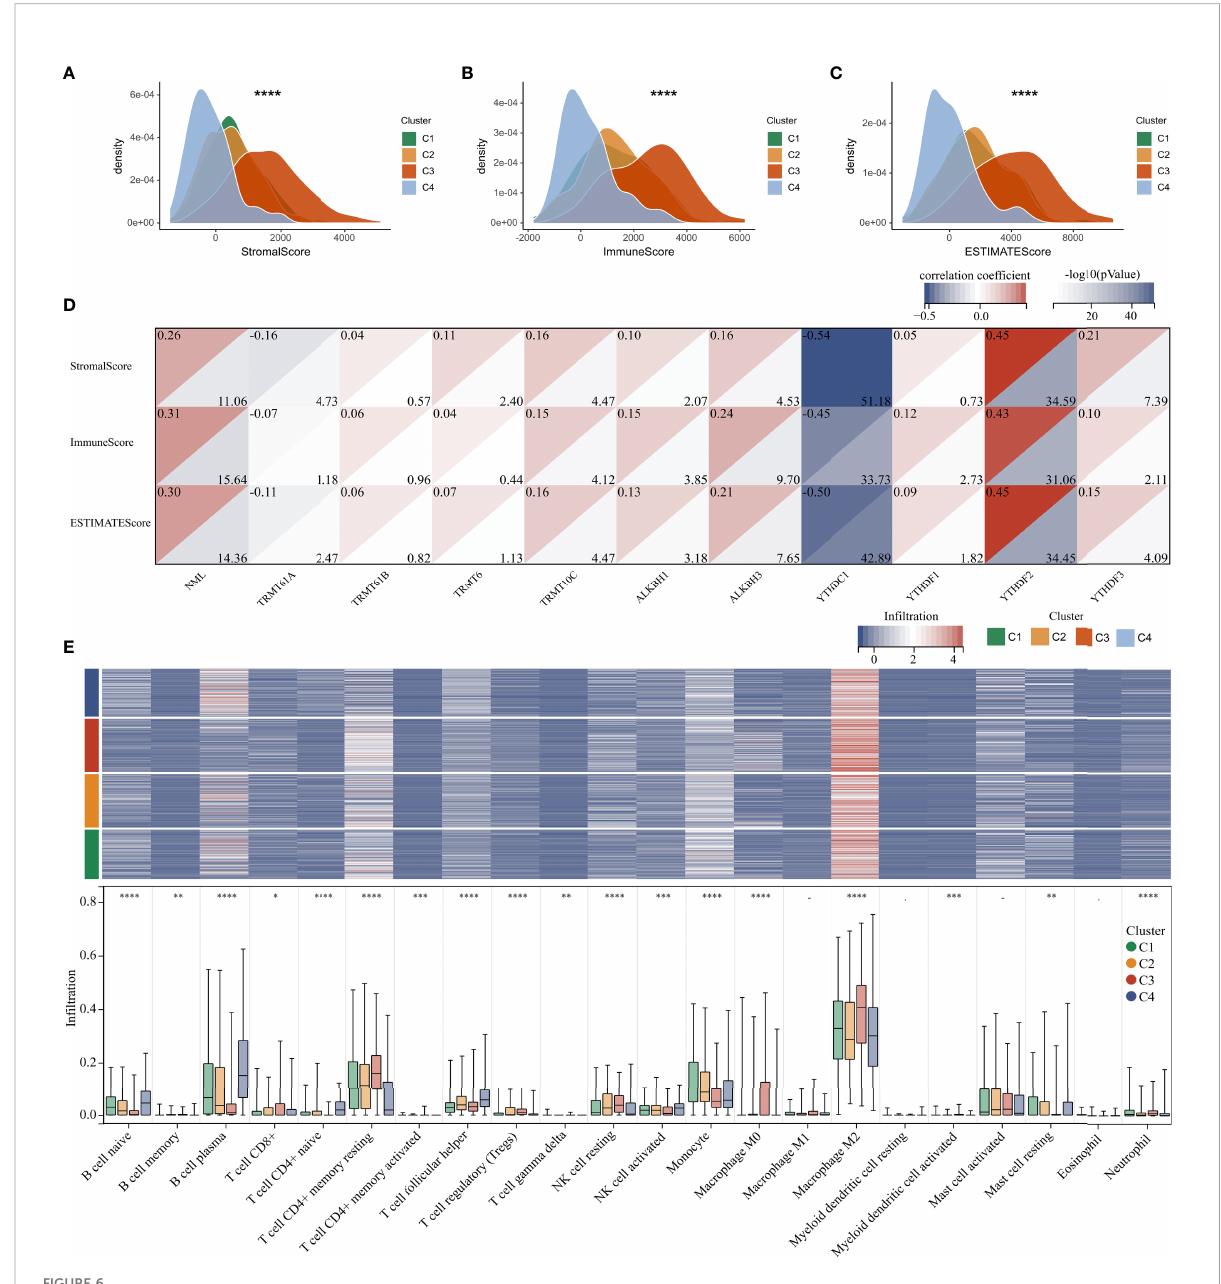
FIGURE 6 Immune microenvironment analysis in glioma. (A – C) Differences in Stromal, Immune, and ESTIMATE scores between clusters. (D) Correlation between m 1 A regulators and microenvironment scores. (E) Heatmap and boxplot showing the in fi ltration of 22 immune cells between different clusters. *, P< 0.05; **, P< 0.01; ***, P< 0.001; ****, P<